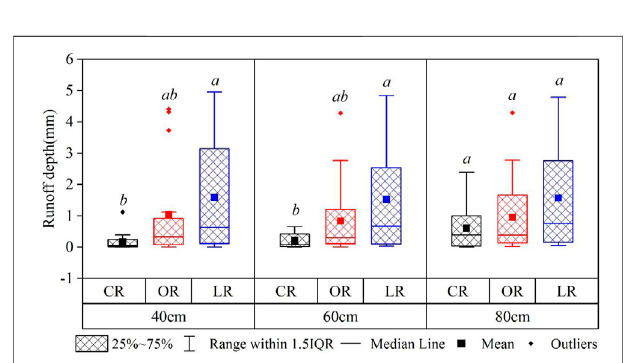
FIGURE4| Runoff depthunderCR, LR, and ORand three ridge widths, and boxes labeled with different letters within groups indicate signi fi cant differencesat p < 0.05.CR,OR,andLRrepresent cross-ridgetillage,oblique- ridge tillage, and longitudinal-ridge tillage. 40, 60, and 80 cm represent 40 cm ridge width, 60 cm ridge width, and 80 cm ridge width, respectively.